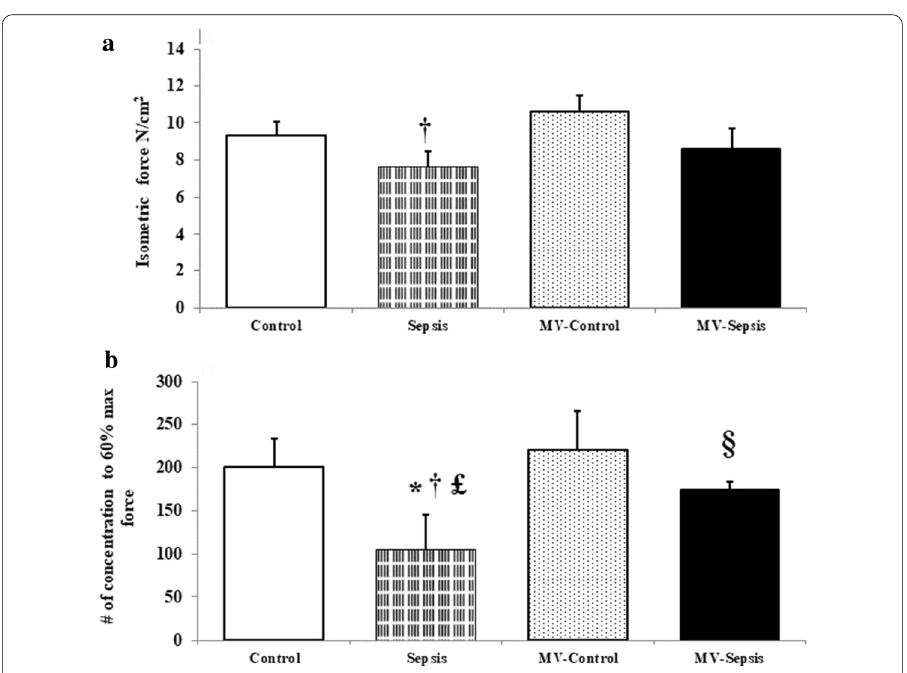
Fig. 2 Diaphragm isometric force and diaphragm fatigue. Isometric force at 70 Hz stimulation taken from force–frequency analysis in diaphragm strips from sepsis, control, MV‑control and MV‑sepsis ( a ). Data are means SEM from 4 animals per group. † p < 0.05 sepsis versus MV‑control; Number of contraction to reduce ± force to 60% of initial isometric force when isolated diaphragm strips underwent a fatiguing stimulation protocol (30 Hz for 350 ms every 2 s for 5 min) ( b ). Data are means sepsis versus control; † p < 0.05 sepsis versus MV‑control; £ p < 0.05 MV‑sepsis versus sepsis, for 4 animals per